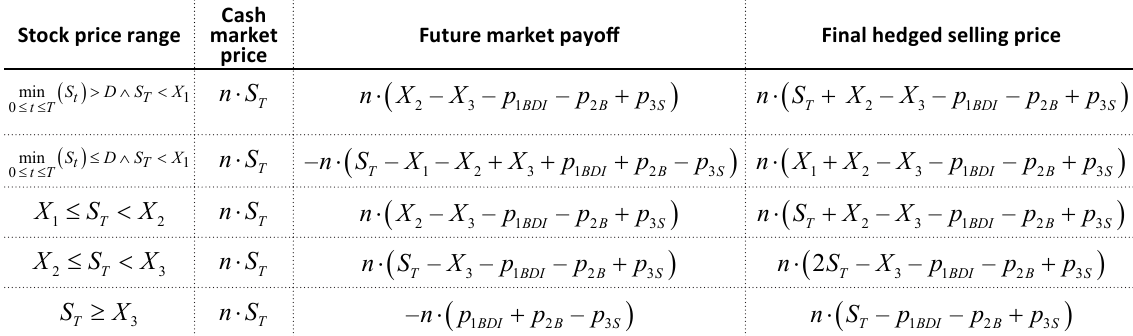
Source: Own design.